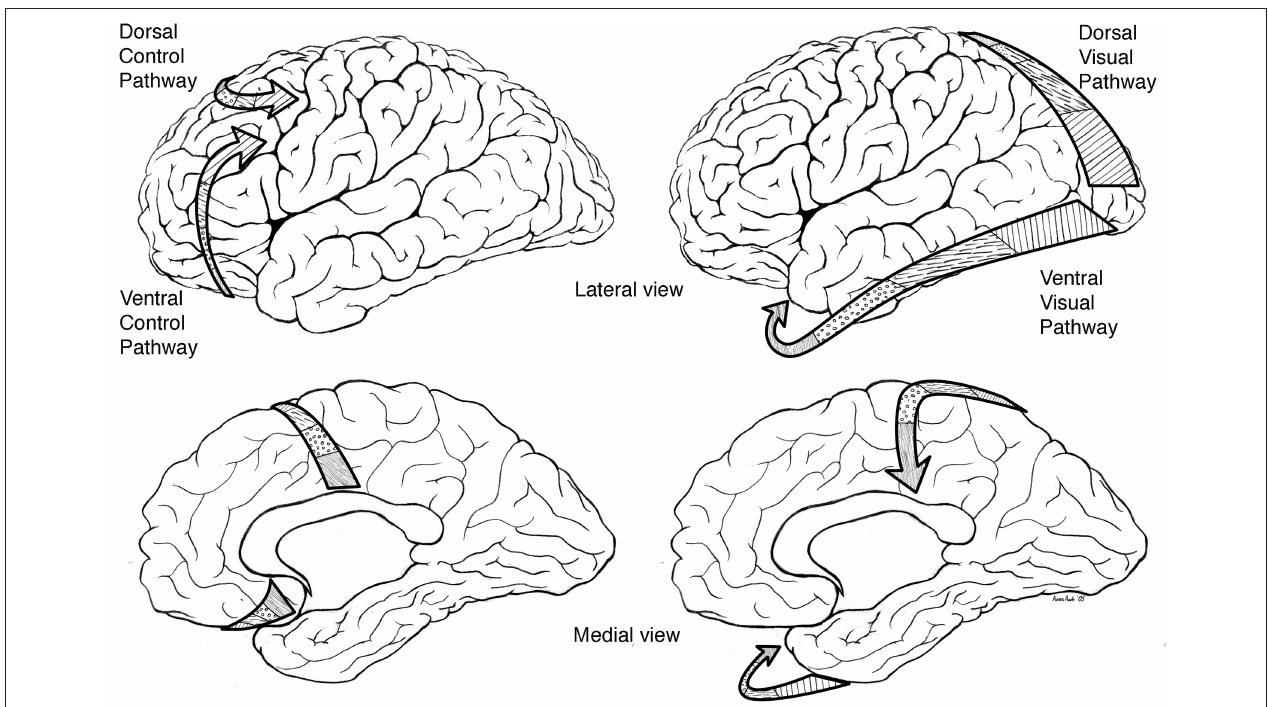
Figure 1 | Left: primary direction of corticolimbic traffic for organizing output from limbic integration toward specific action modules in the motor cortex. Two separate control paths are routed from limbic networks through the frontal lobe to motor cortex. A ventrolateral pathway proceeds from olfactory cortex through the orbital frontal lobe to lateral frontal cortex before reaching the ventral premotor and motor cortices (ventral/bottom arrows).